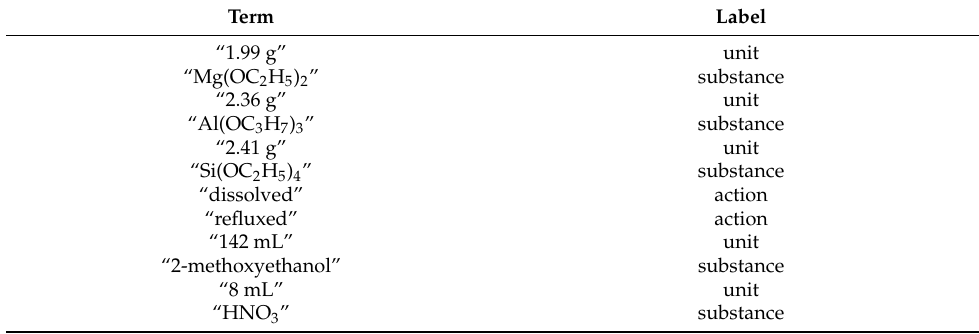
Table 4. Example list of chemical terms after labeling for patent US5132253A.